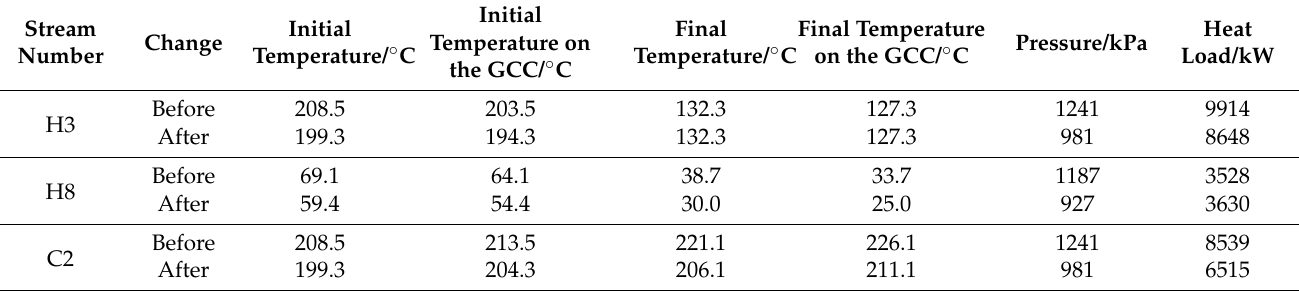
Figure 8. Temperatures and heat load changes of condenser and reboiler after lowering operating pressure. Table 6. Comparison of relevant stream data before and after lowering the operating pressure of column T101 by 260 kPa